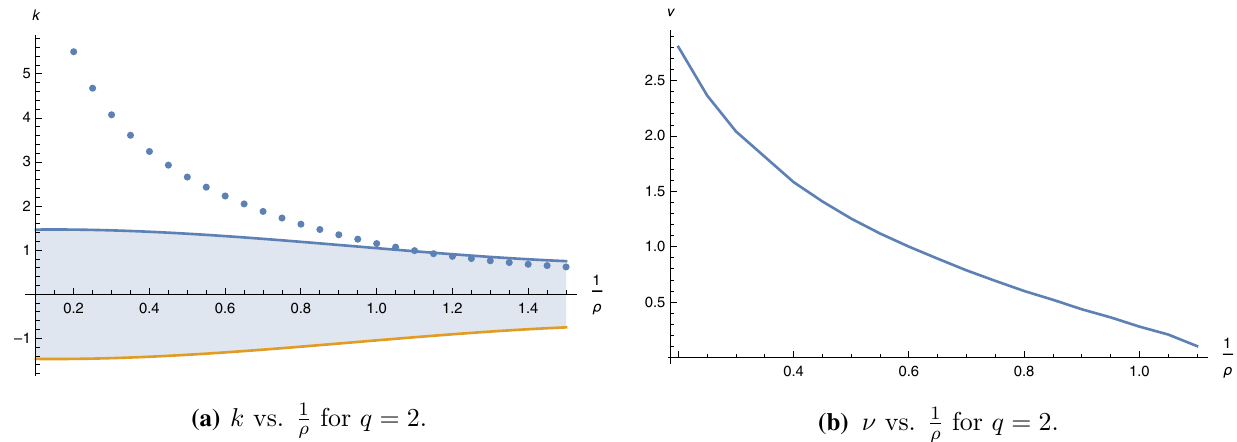
Fig. 1 The shaded region on the left figure corresponds to the oscillatory region, with blue dots representing the Fermi momenta( k F ) for q = 2. On right we have ν vs. 1 /ρ plot, where the quasiparticles start becoming stable with a higher value of charge density ρ